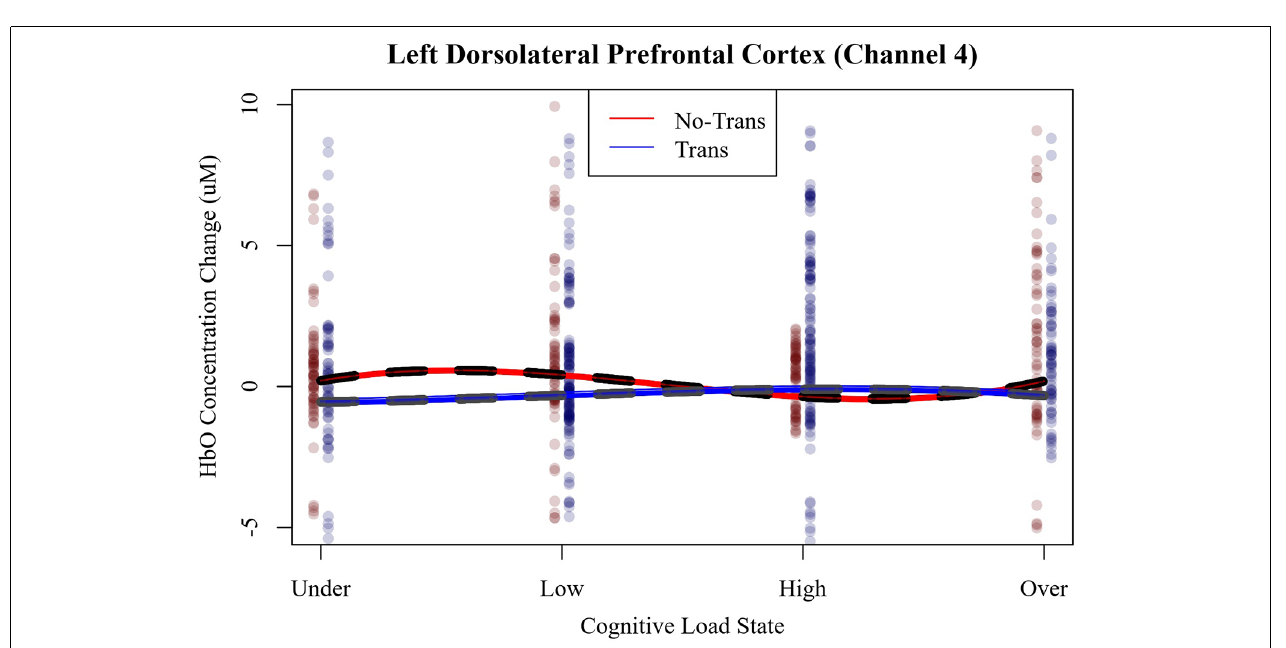
FIGURE 9 | LDLPFC (Channel 4) relative HbO as a function of cognitive load state and workload transition condition.